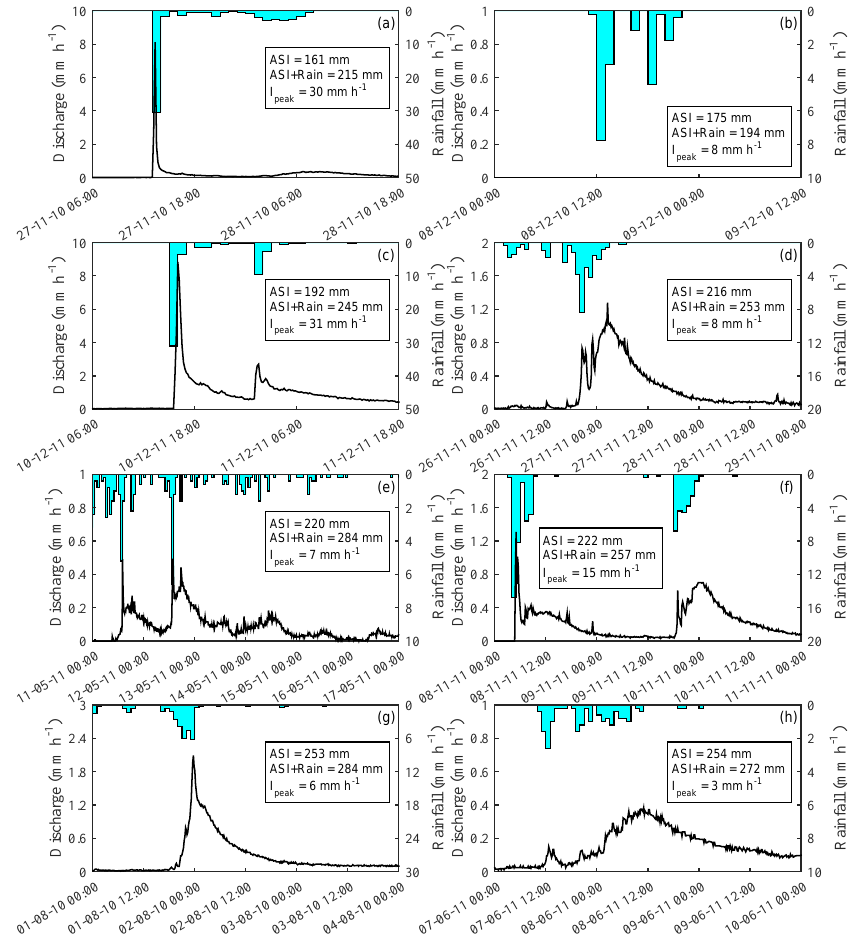
Figure 4. Characteristics of eight selected rainfall–runoff events sorted by their Antecedent Soil moisture Index (ASI). Rainfall is shown in blue. It should be noted that the axis scales vary between events. All events (except those on 26 November and 10 December 2011) had zero or very low initial discharge. For the events on 26 November and 10 December 2011, the initial discharges were 0.07 and 0.13mmh − 1 , respectively. Note that the axes vary between